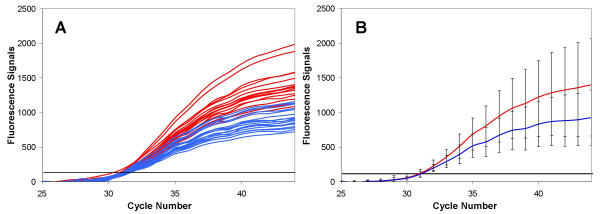
Fluorescent signal scatter in symmetric PCR assays. Replicate sets of homozygous normal (red lines) and heterozygous (blue lines) DNA for the TSD Δ1278 allele of the human HEXA gene were amplified using symmetric PCR. Reactions were monitored using a molecular beacon probe against the normal HEXA allele. The molecular beacon probe is allele-discriminating and recognizes 100% of the alleles in the homozygous normal samples but only 50% of the alleles in heterozygous samples. As a result, the probe fluorescence signals should theoretically be twice as intense in homozygous normal samples compared to heterozygous samples. Each reaction contained 1000 genome-equivalents of genomic DNA. Panel A: Kinetic plots of accumulated amplification products detected by the molecular beacon probe in replicate samples. Signal scattering among replicate samples due to stochastic factors influencing PCR in individual tubes prevents unambiguous identification of homozygous and heterozygous samples based on final fluorescence signal intensity. Panel B: Statistical analysis of data in Panel A. Solid lines represent the average fluorescence intensity values (red: homozygous normal samples; blue: heterozygous samples), error bars corresponds to three-standard deviations of the mean of the fluorescence signals at each amplification cycle which defines the range of fluorescence signals encompassing 99.7% of samples for each genotype. The extensive overlap between the error bars of homozygous normal and heterozygous samples demonstrates that these samples cannot be identified based solely on final fluorescence signal intensity at any amplification cycle.